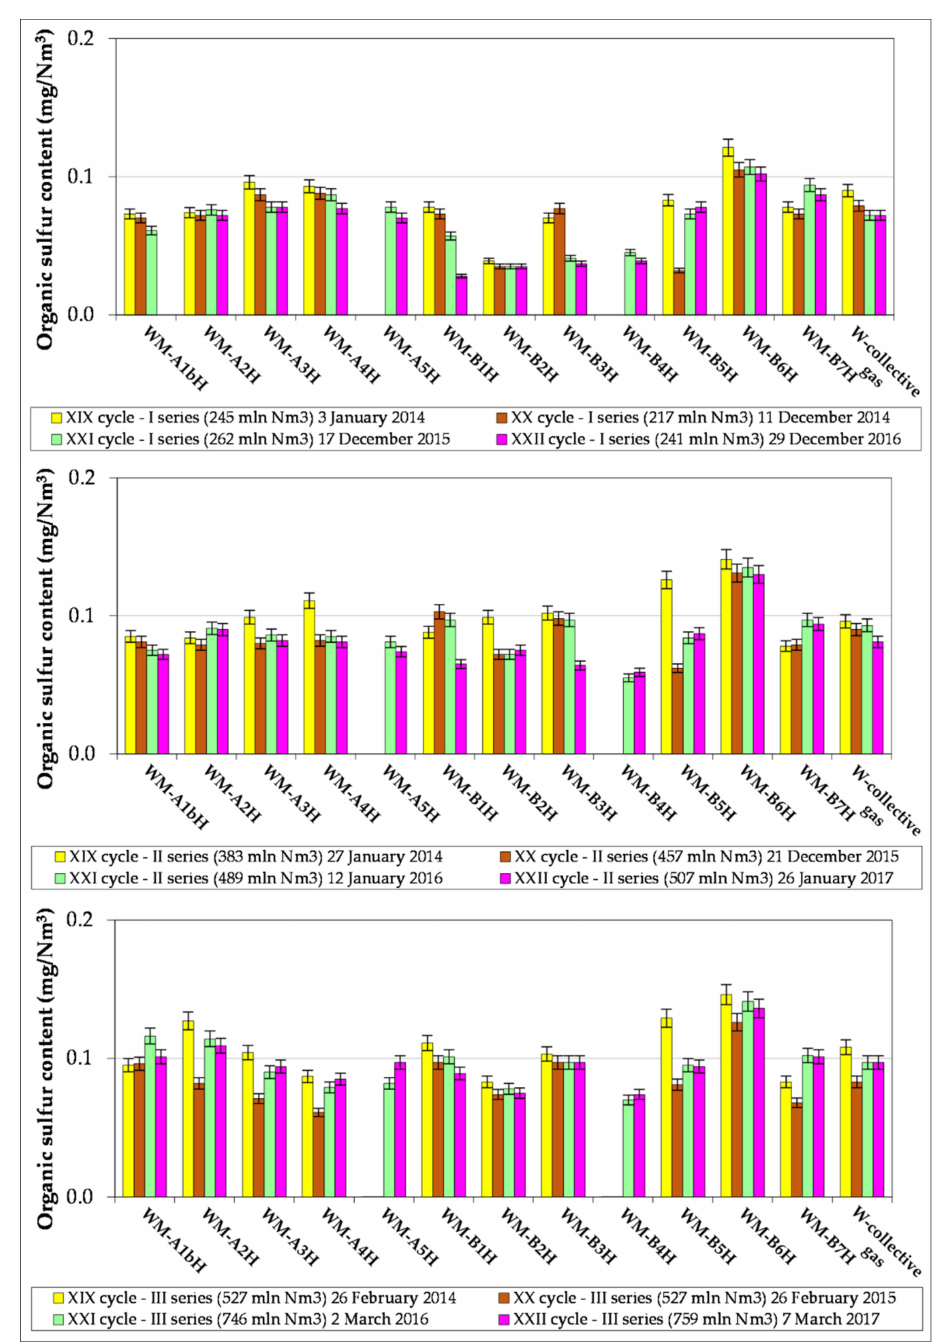
Figure 4. A comparison of the content of organic sulphur compounds in the gas from the exploitation horizontal wells of the A and B clusters of UGS Wierzchowice (series